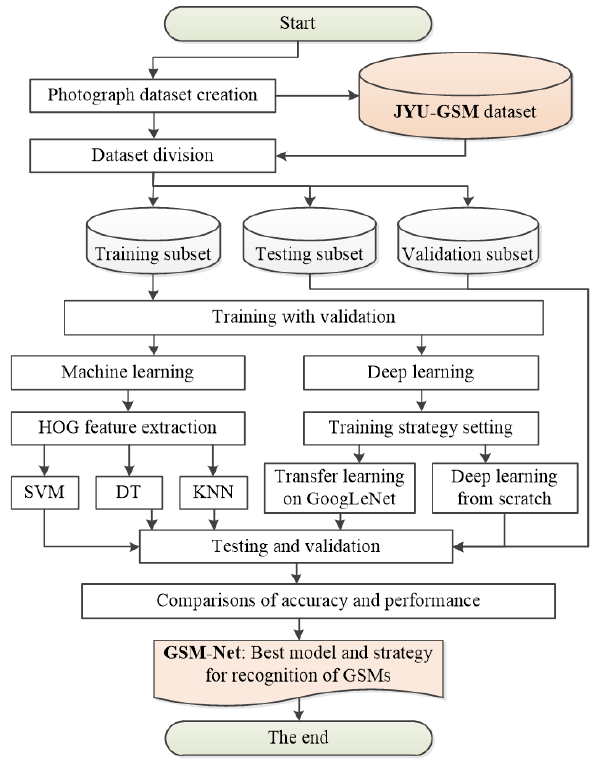
Figure 1. Overall workflow chart of the present study. JYU-GSM is the abbreviation of the JiaYing University Geothermal Surface Manifestation; HOG is short for Histogram of Oriented Gradients, SVM is short for Support Vector Machine, DT is short for Decision Tree, and KNN is short for K- Nearest Neighbor; GSM-Net is the abbreviation of the geothermal surface manifestation deep neural network model retrained from GoogLeNet; GSMs denotes geothermal surface manifestations.